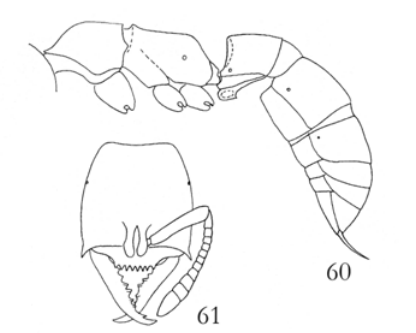
Figs. 60-61: Worker of Amblyopone zaojun Terayama; 60. Head and body in profile view; 61. Head in full-face view. (Cited from Terayama, 2009, slightly